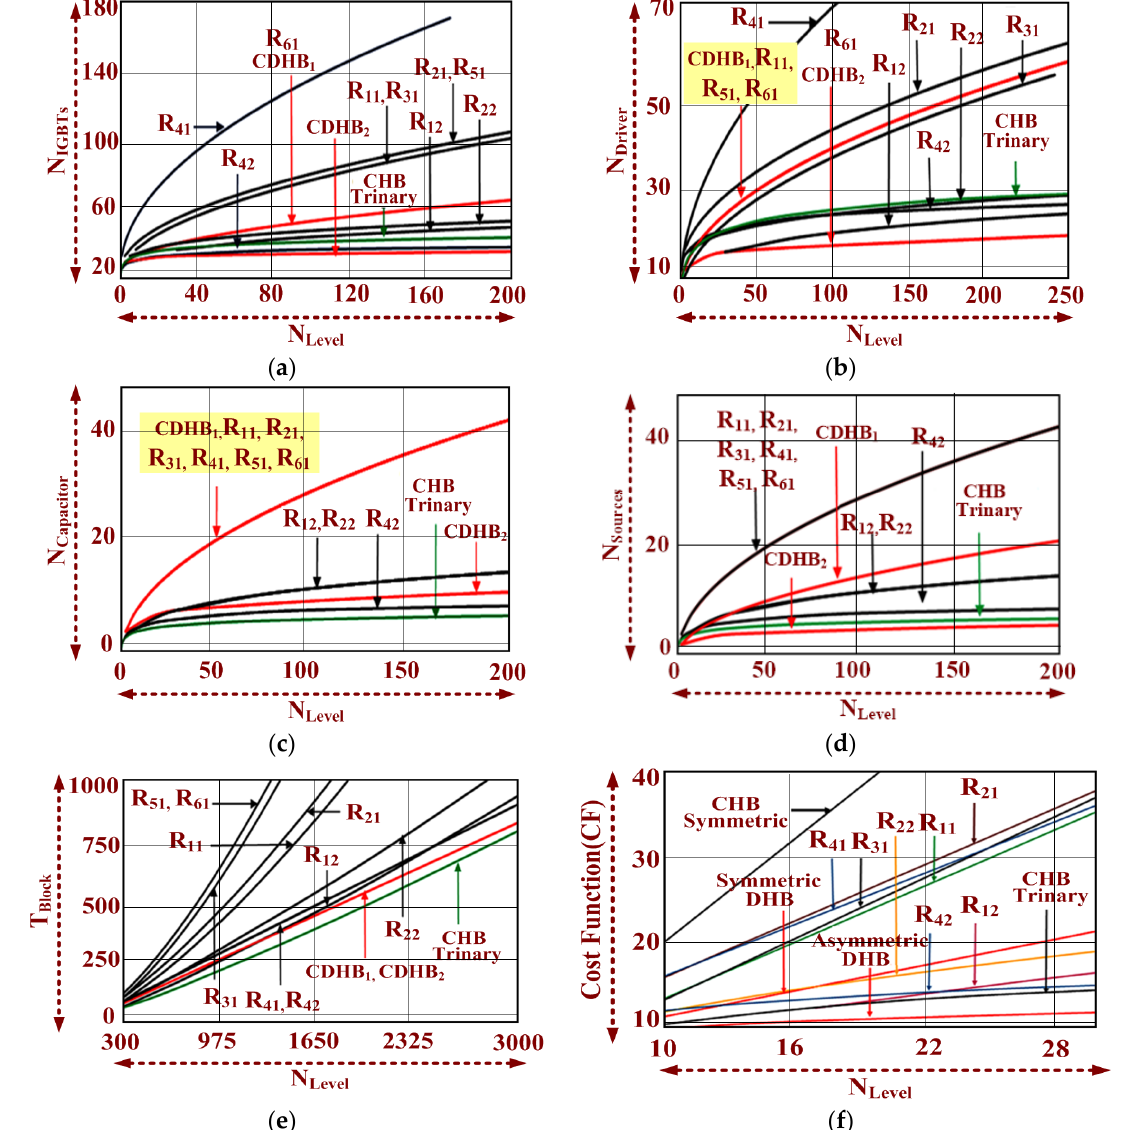
Figure 8. Comparison ( a ) N IGBTS versus levels ( b ) N driver versus levels, ( c ) N capacitor versus levels ( d ) N source versus levels, ( e ) T Block versus levels ( f ) Cost versus levels.